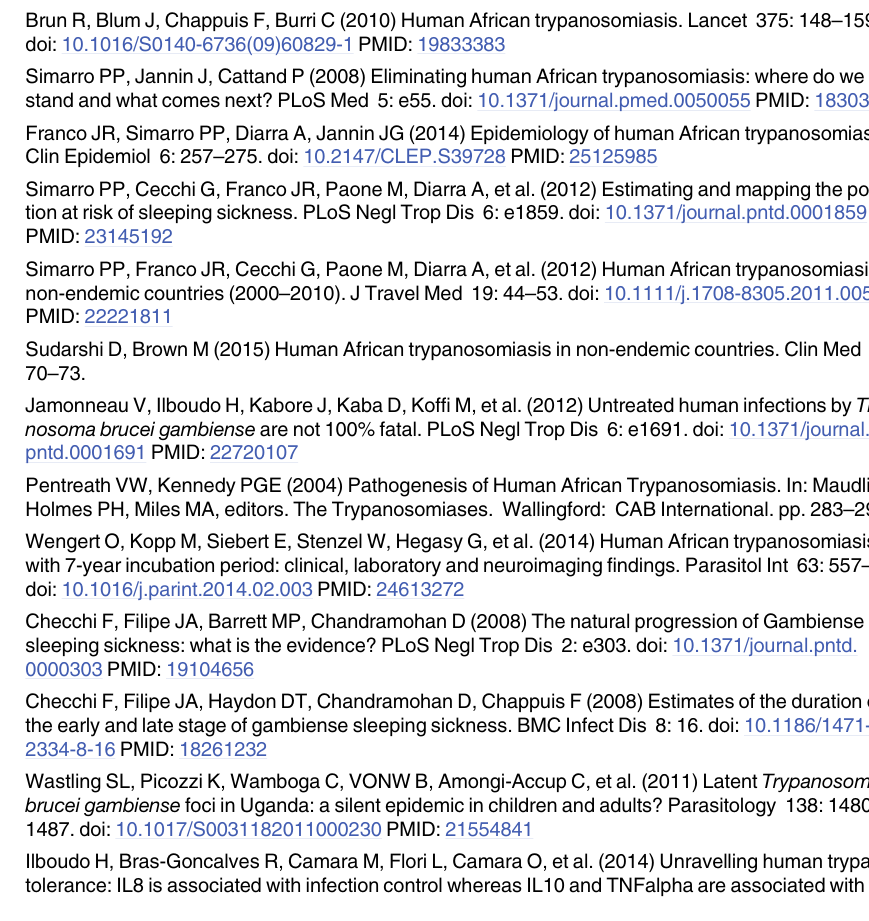
S3 Table. Investigation of horizontal transmission of T . b . gambiense 1135 from infected male mice (n = 5) to healthy female mice (n = 8) examined by ex-vivo organ BLI and PCR seven months post-crossing. Positive samples are indicated in bold a . S4 Table. Fold increase of BLI signal to control for five female and five male offspring of T . b . gambiense 1135 infected females (n = 10) and healthy male mice (n = 5) examined at 2 – 3 months of age. Positive values+ are indicated in bold a